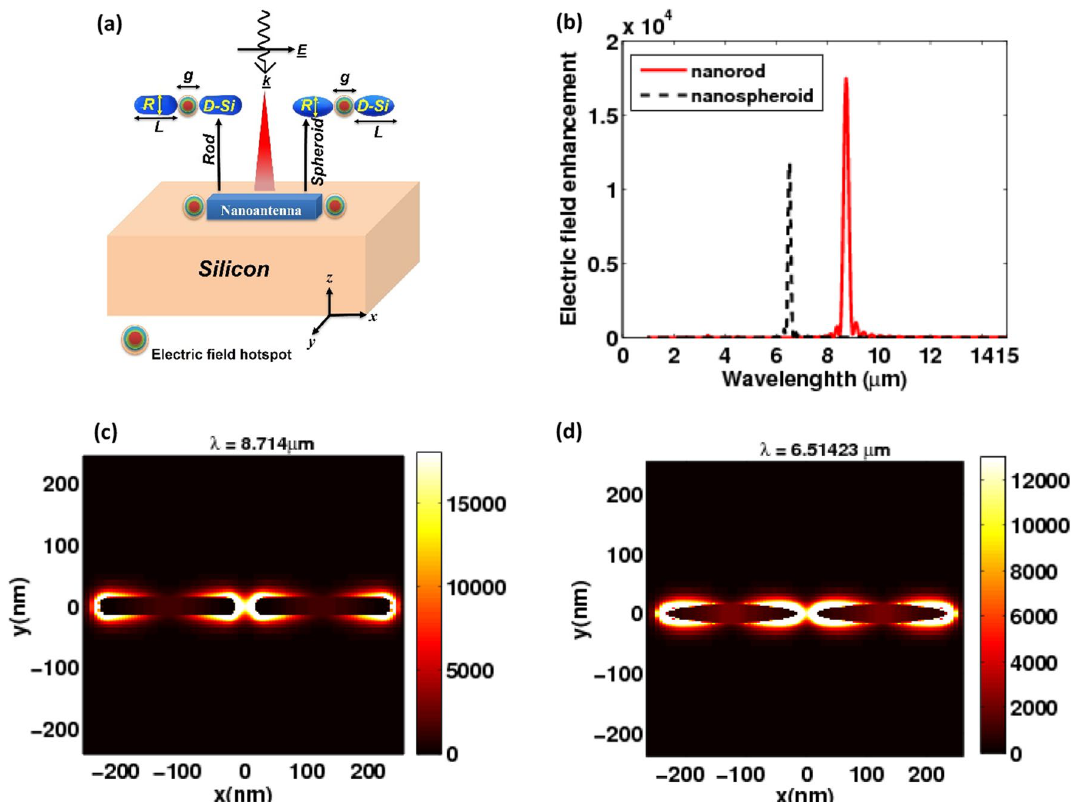
Figure 4. ( a ) Schematic of a nanoantenna structure consisting of dielectric nanorod or dielectric nanospheroid. ( b ) a comparison between the electric field enhancement at the center of the gap as a function of the wavelength for the nanorod and the nanospheroid. ( c ) the profile of the local field enhancement inside the gap of the nanorod. and ( d ) the profile of the local field enhancement inside the gap of the nanospheroid.